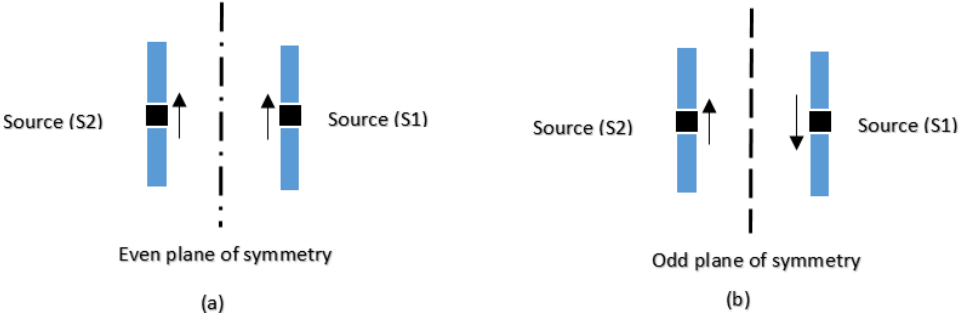
Figure 2. Symmetry and antisymmetry between two sources